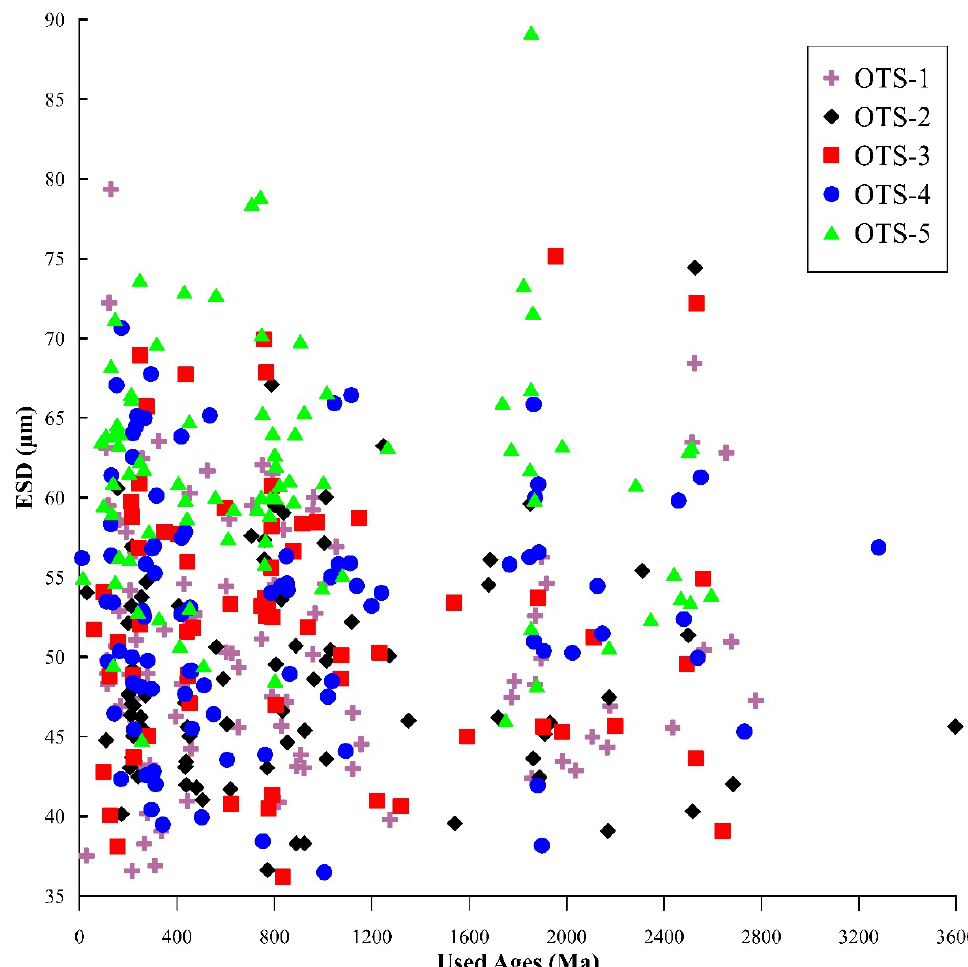
Figure 7. Distribution plots of detrital zircon U-Pb ages and ESD which be used in this study. Please refer to Table S2 for detailed data.